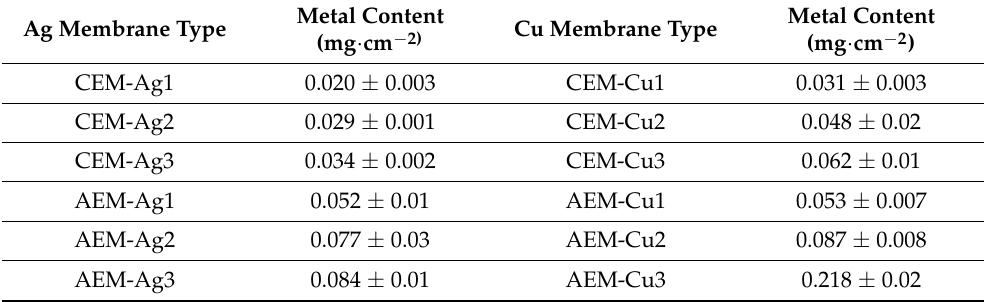
Table 5. Ag and Cu metal content of the Ag- and Cu-functionalized UF heterogeneous IEMs.